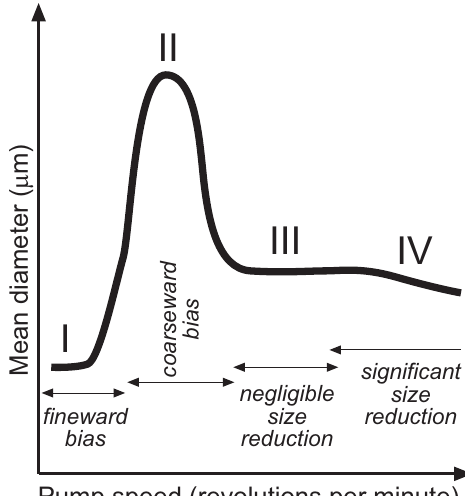
Fig. 7. Conceptual sketch showing the four main stages character- ising the typical asymmetric bell shaped curve resulting from the progression of mean diameter values during pump speed tests of granular materials. See text for